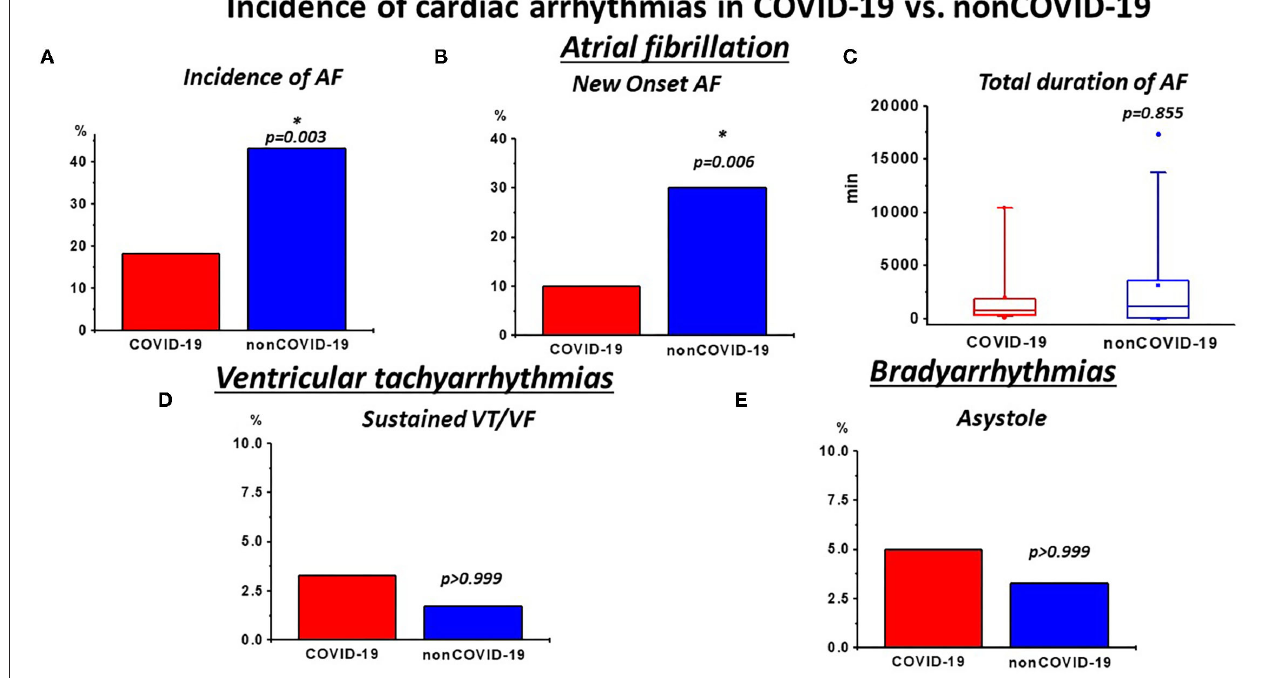
FIGURE 1 | Incidence of relevant cardiac arrhythmias during intensive care (ICU) rhythm monitoring in COVID-19 vs. non-COVID-19: (A) incidence of atrial fibrillation (AF) and (B) newly diagnosed AF was high in both groups. However, non-COVID-19 patients presented a higher burden of AF and newly diagnosed AF, (C) while the total duration of AF was not different in affected patients. (D) The incidence of sustained VTs/ventricular fibrillation (VF) was similar in both groups (E) and the frequency of asystole was also not significantly different. * p <